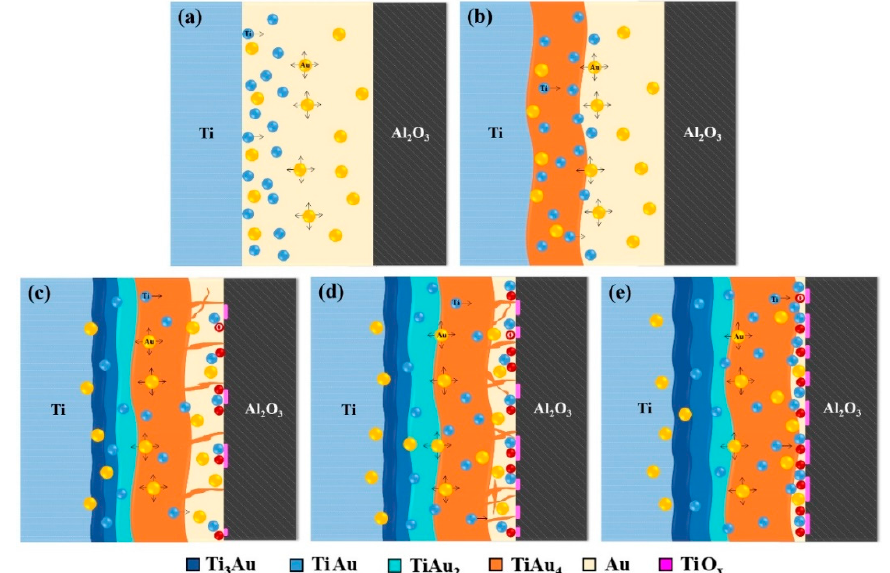
Figure 7. Schematic of the microstructure evolution for the titanium / Au / Al 2 O 3 joint. ( a ) Mutual diffusion of Ti and Au; ( b ) formation of the TiAu 4 layer; ( c ) formation of reaction layers of the joint; and ( d ) and ( e ) growth of reaction layers with the increase of brazing temperature or holding time.